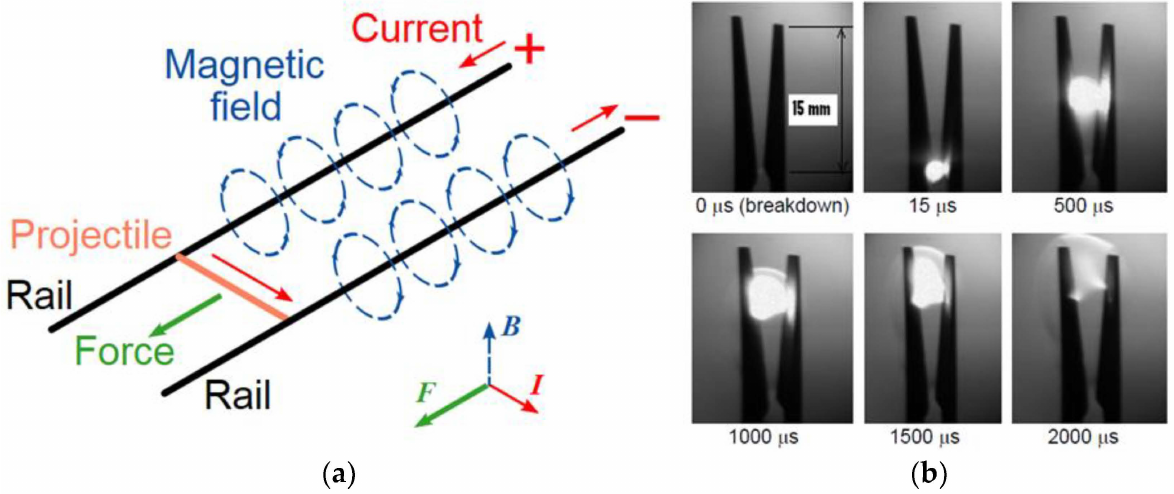
Figure 4. Schematic diagram of a ( a ) railgun and the arc moving process of ( b ) a rail plug